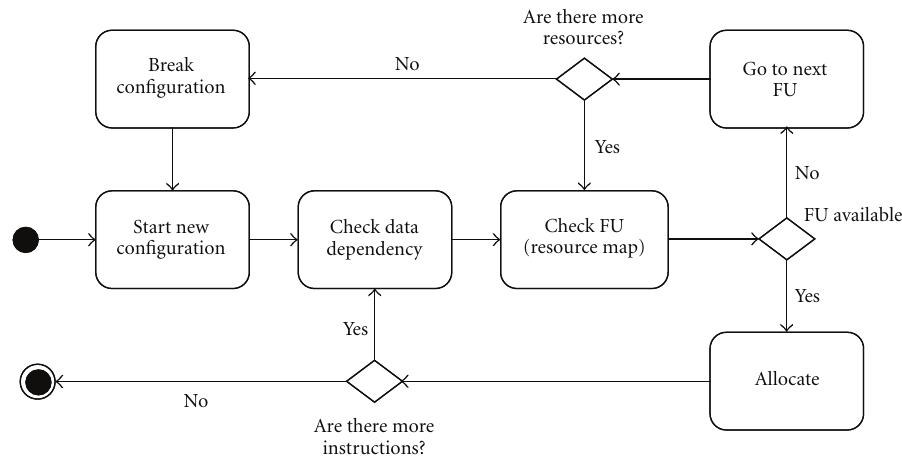
Figure 5: Configuration generation algorithm implemented in Binary Translator (defect-free approach).